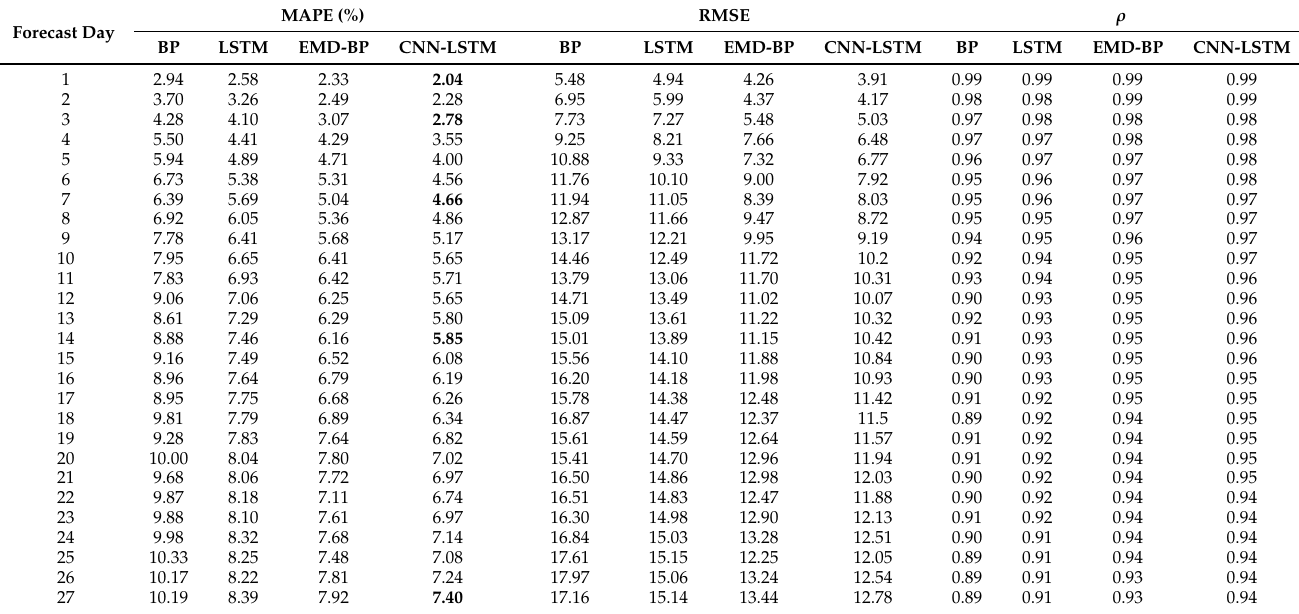
Table 2. Comparison of performance between BP, LSTM, EMD-BP and CNN-LSTM by multi- step forecast.